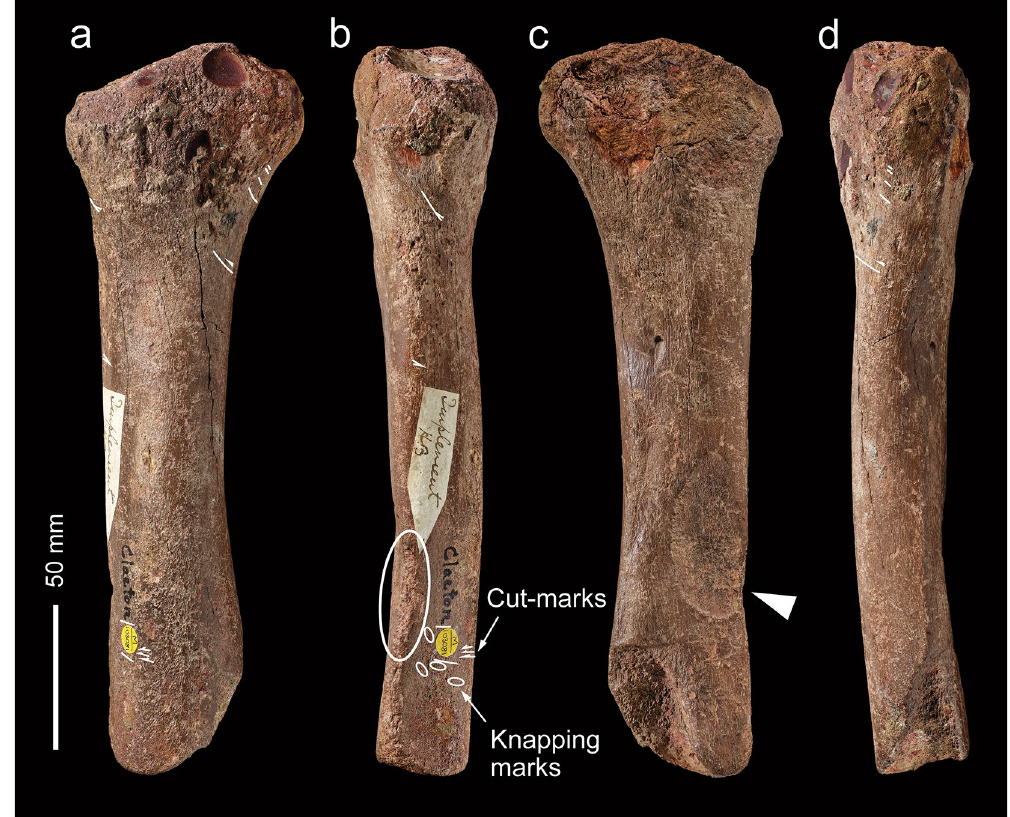
Figure 5. Rhinoceros radius (NHMUK PV M 103081) in anterior ( a ), medial ( b ), posterior ( c ) and lateral ( d ) view. The arrow indicates the point of impact that removed one of the cortical flakes, the large oval encloses the area of battering damage, and small ovals enclose isolated knapping scores. The label (‘ Implement HB ’) points to the damage recognized by Henri Breuil (HB). Burial in an aquatic environment is indicated by impressions of bivalves in the concreted sediment adhering to the proximal